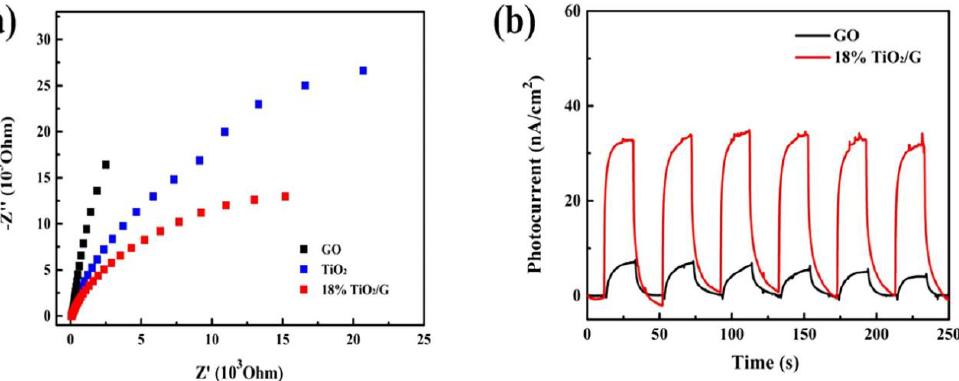
Figure 6. ( a ) EIS plot and ( b ) photocurrent plot. Reprinted with permission from [114]. Copyright Elsevier.